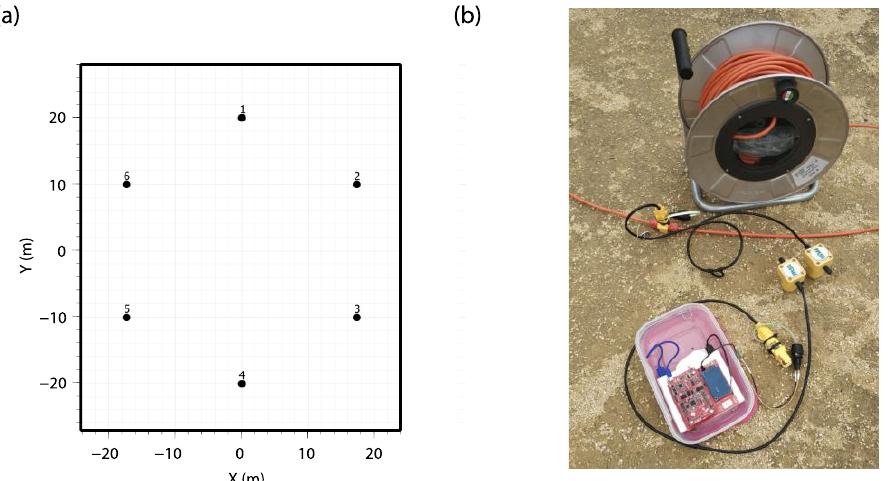
Figure 11. ( a ) Array geometry ( b ) One measurement point with one geophone (right one) connected to the P.A.S.I. seismic cable and the other geophone (left one) connected to one of the nodes.